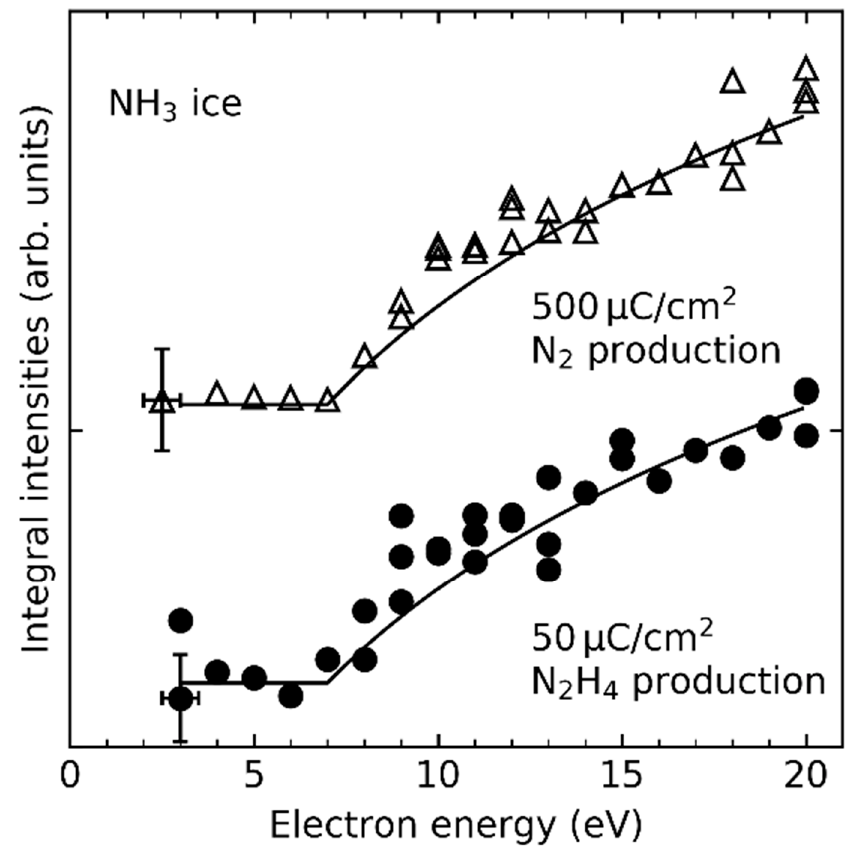
Figure 5. Energy dependence of the integrated desorption signals of N 2 and N 2 H 4 obtained from pure 10–14 monolayer thick NH 3 ice for electron exposures of 500 and 50 µ C/cm 2 , respectively (this work). The values for N 2 H 4 were obtained by TDS while N 2 was monitored both in ESD and TDS. The solid lines serve as a guide to the eye.